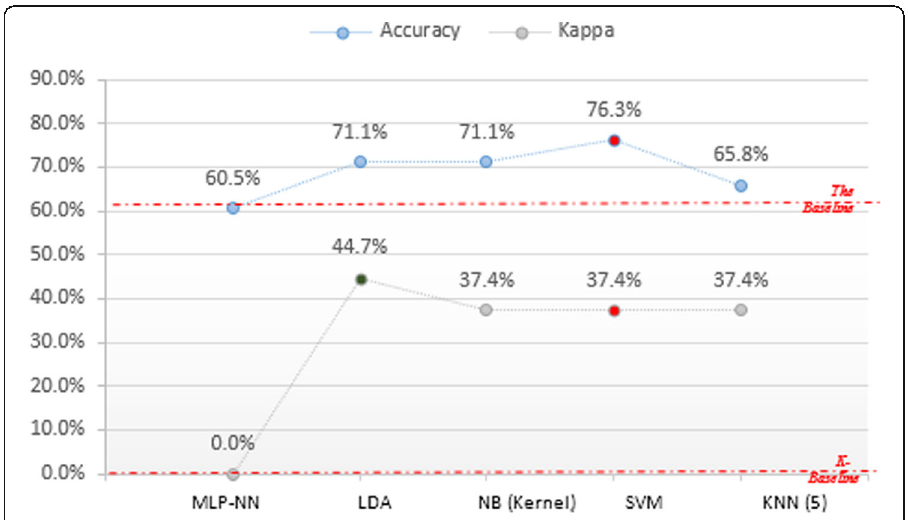
Fig. 10 Accuracy and Kappa evaluation for different machine learning models while training the dataset2 for predicting students ’ grade in dissertation